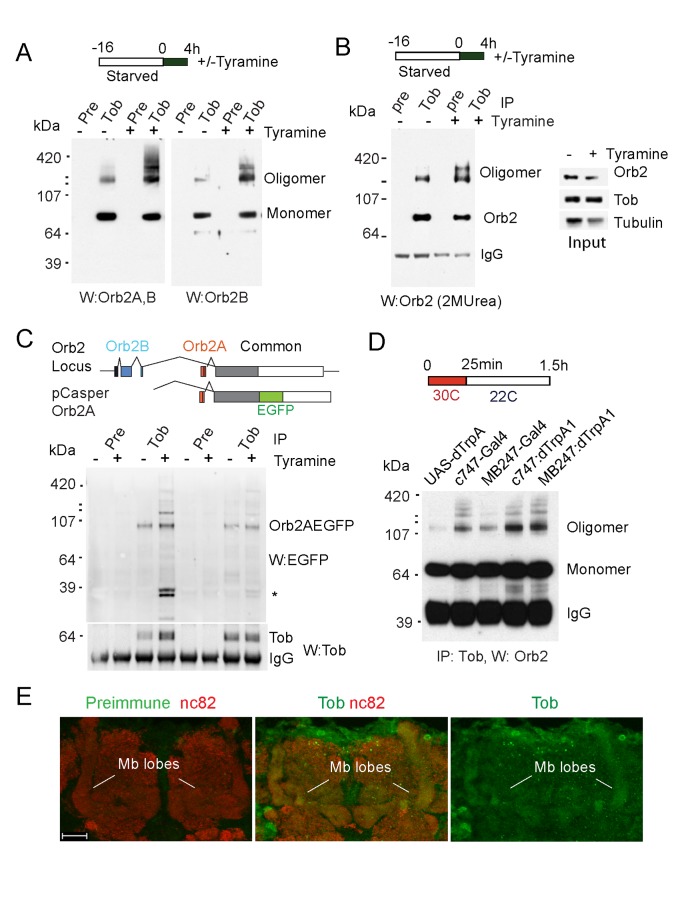
Tob-Orb2 association is regulated by neuronal activity, and Tob is present in the same synaptic compartment as Orb2.(A) Neuronal stimulation increases Tob-Orb2 association. Tob was immunoprecipitated from unstimulated (control) or 10 mM tyramine-stimulated head extracts and blotted with the anti-Orb2 antibody (Orb2A,B) that detects both forms of Orb2 or an antibody that detects only Orb2B (Orb2B). The preimmune serum (pre) from the same animal serves as control for Tob antibody specificity. (B) Tob-associated oligomeric Orb2 is amyloidogenic. Tob was immunoprecipitated from either unstimulated (control) or tyramine-stimulated head extracts, treated with 10% SDS and 2 M urea and blotted with the anti-Orb2 antibody. Western analysis of lysates indicates the expression levels of Orb2, Tob, and tubulin. (C) Tyramine increases Tob-Orb2A association. (Top panel) A schematic diagram of the genomic pCasperOrb2A construct, which expresses an EGFP-tagged Orb2A. The Orb2B-specific exons are indicated in blue, Orb2A-specific exon in red, and the common region in gray. (Bottom panel) Tob was immunoprecipitated from unstimulated (−) or tyramine-stimulated (+) total brain lysates with preimmune (pre) or immune serum (Tob) and probed with anti-EGFP antibody. The position of the monomeric Orb2AEGFP fusion protein is indicated. The EGFP-antibody reacting high molecular weight proteins are most likely the oligomeric form of the Orb2AEGFP protein. The asterisk indicates low molecular weight protein that is either a degradation product of Orb2AEGFP or a cross-reactive band. In the lower panel Tob is visible only in immune serum lane, indicating specificity of the pull-down. Orb2AEGFP is not detectable by Western analysis. (D) Stimulation of mushroom body neurons enhances Tob-Orb2 association. A schematic of the stimulation protocol is shown above the gel picture. The mushroom body neurons were stimulated using the temperature-sensitive dTrpA1 channel, which depolarizes and thereby activates neurons at a temperature >25°C. More Tob-associated Orb2 oligomers were observed at 30°C in flies harboring both the Gal4 driver and TrpA1 transgene compared to flies with just the Gal4-driver or TrpA1. The c747-Gal4 and MB247-Gal4 drive expression in all neurons of the adult Drosophila mushroom body. (E) Tob is widely distributed in the adult brain. Frontal cryosections of adult fly heads were immunostained with the preimmune serum or anti-Tob (green) antibody. Tob is present in the cell body and at a low level in the synaptic neuropil region of mushroom body (Mb lobes) Kenyon cells. Nc82 (red) marks the synaptic neuropil region. Scale bar, 20 µm. Also see Figure S4.